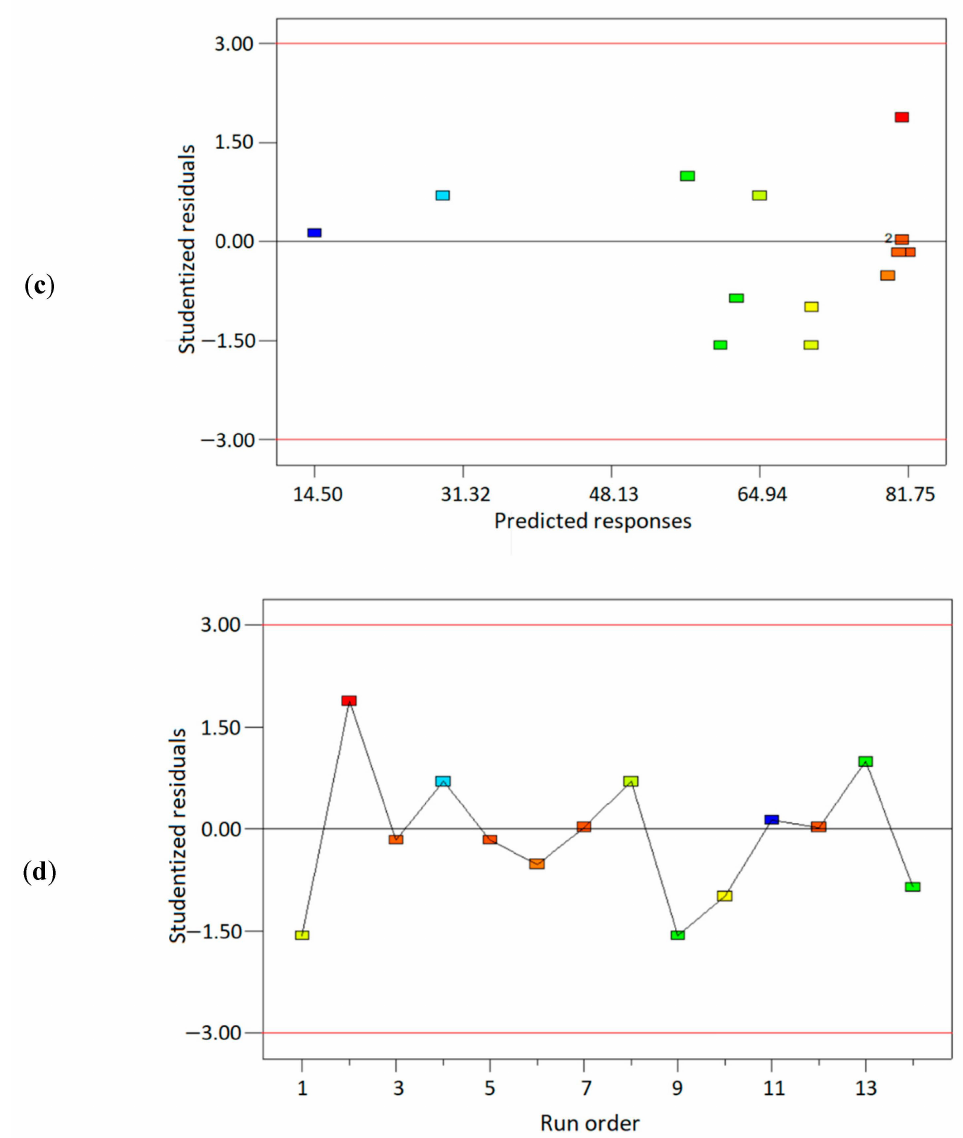
Figure 8. The residuals analysis diagnostic plots for ( a ) predicted versus observed responses, ( b ) normal probability plot, ( c ) residuals versus predicted responses, and ( d ) residuals versus run